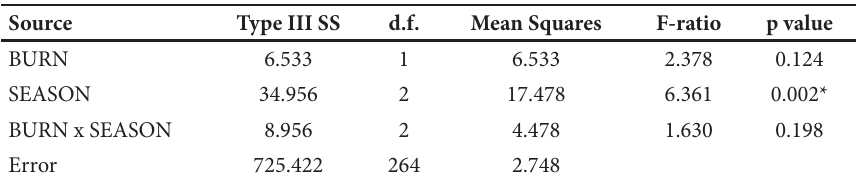
Table 4. 2-Way ANOVA results showing that only season was a significant factor in affecting species diversity. An asterisk “*” denotes significance.